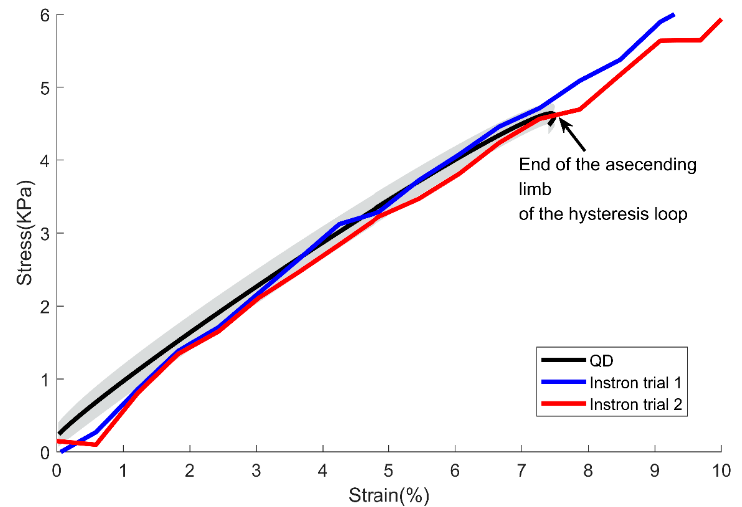
Figure 7. Mean ascending limb of the stress and strain curve from the hysteresis loop obtained from the QD. The black bold line indicates the mean value and the shade indicates ±1 Confidence Interval of the data obtained from the QD. The blue line and the red line indicate each trial from the Instron equipment.